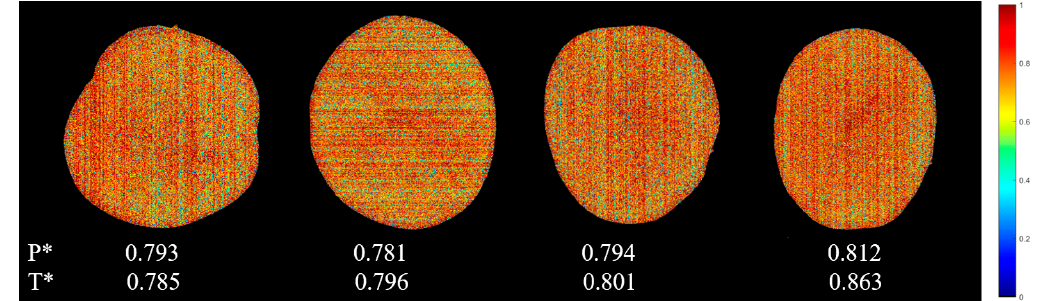
Figure 3. Pixel-wise prediction maps developed on the CARS-LS-SVM models for water content visualization (P* is the predicted average value of all pixels; T* is the actual value measured by the chromatic aberration